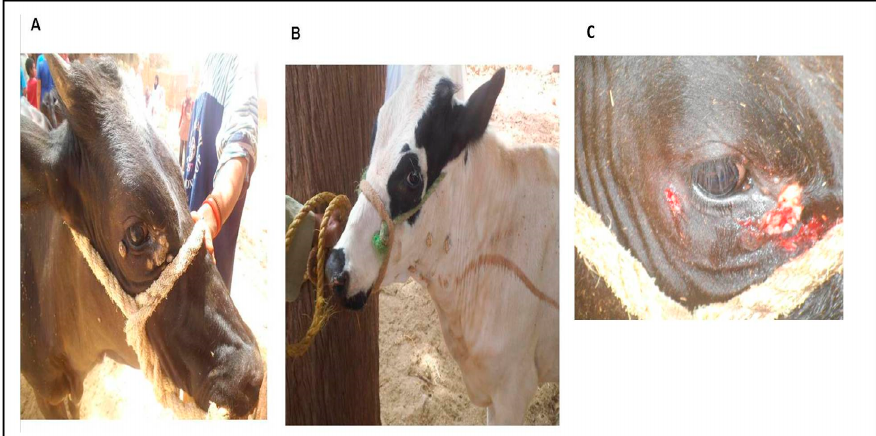
Figure 1. Typical cases of bovine papillomavirus (BPV) infection in cattle with macroscopic cutaneous warts around the eye ( A ), on the neck ( B ), and after surgical removal of cutaneous growths around the eye ( C ).